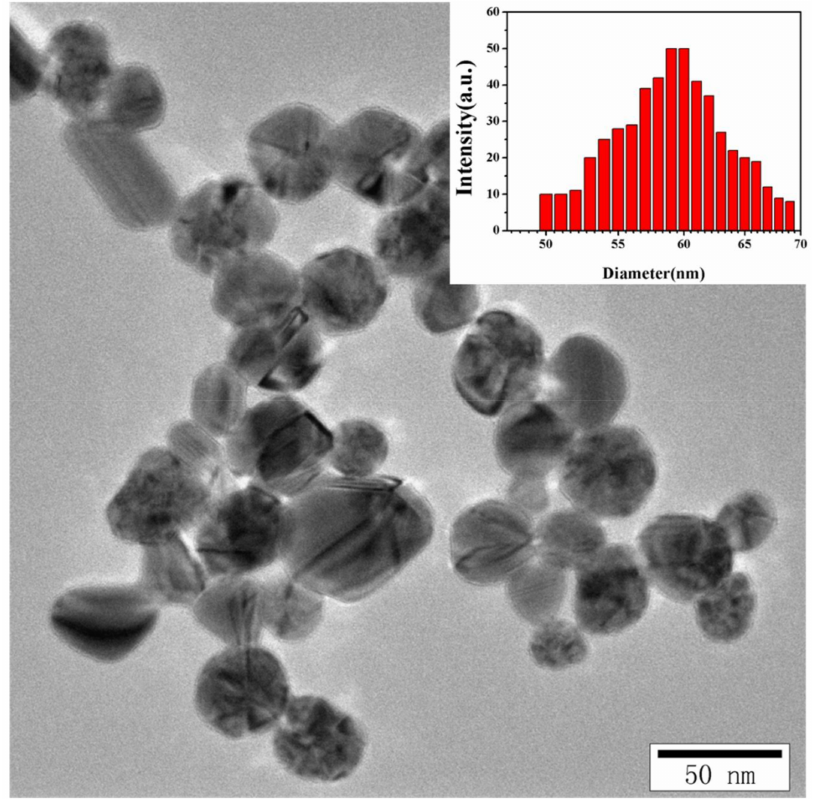
Figure 2. TEM images of the pure Ag NPs with the distribution of hydrodynamic sizes of Ag NPs